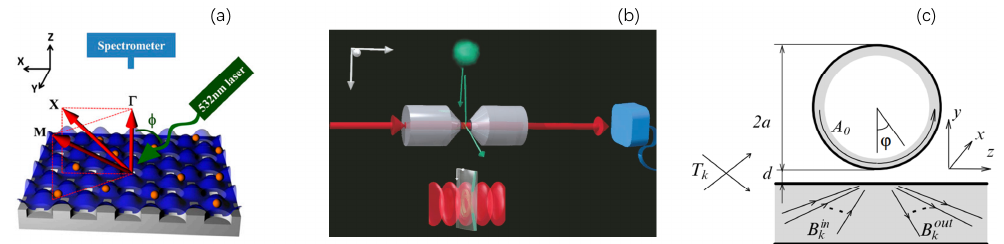
Figure 1. Structural diagrams of the typical optical microcavities: ( a ) Photonic crystal microcavity [16]; ( b ) F-P microcavity [19]; and ( c ) Whispering-gallery mode in the form of microspheres [23].